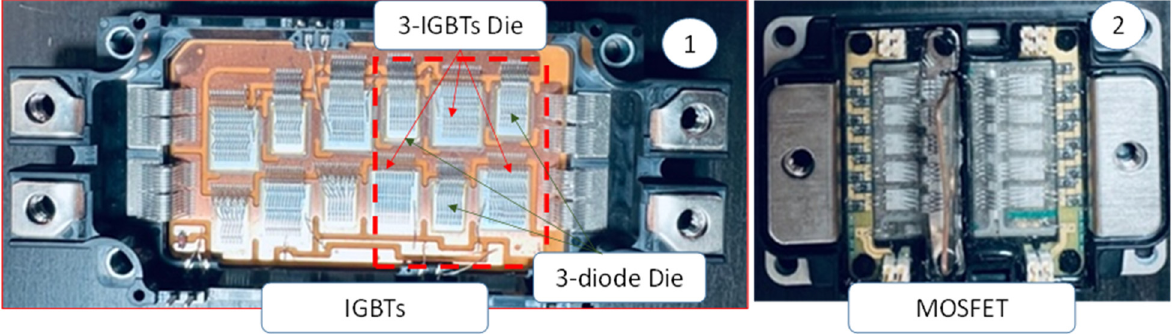
Figure 5. Modules as single dies paralleling. Panel 1 on the left are the IGBTs and Module. Panel 2 on the right are the MOSFETs.